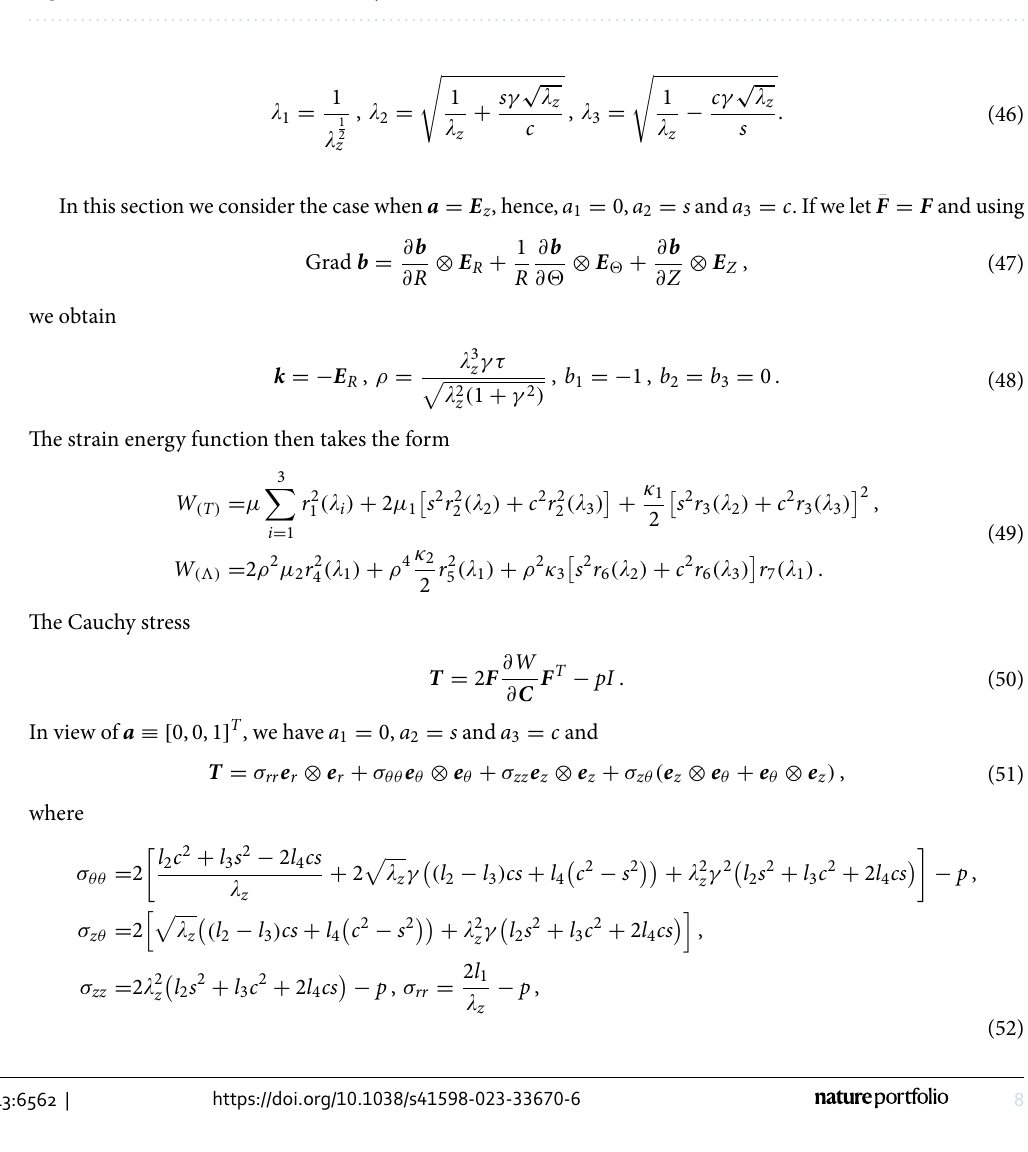
Figure 6. Torsion and extension of a